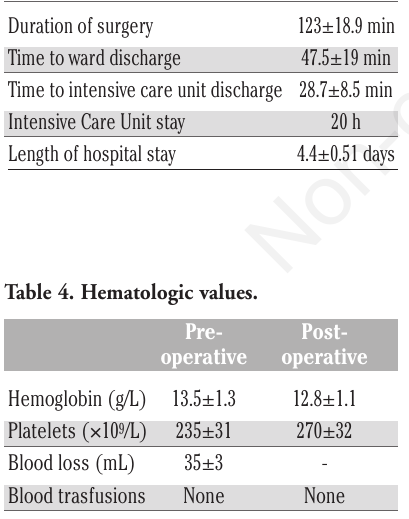
Table 3. Duration of surgery and anesthesia.